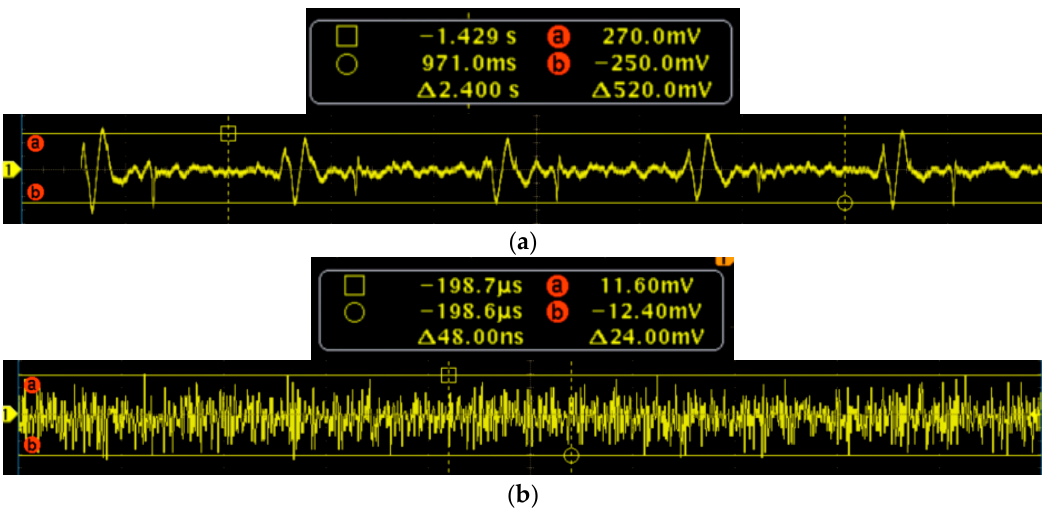
Figure 15. SNR test of the MEMS sensor. ( a ) Heart sound signals; and ( b ) output without the heart sound signals.